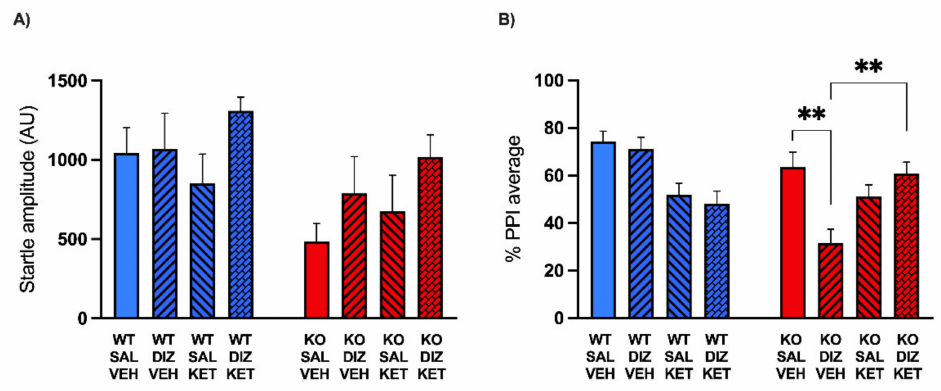
Figure 4. Effects of the medial prefrontal cortex (mPFC) infusion of ketanserin (KET, 0.05 µ g/side) on the changes in startle reflex ( A ) and prepulse inhibition ( B ) induced by dizocilpine (DIZ, 0.1mg/kg, IP) in MAOA KO mice. Data are shown as means ± SEM. Significance levels refer to the results of post hoc comparisons of three-way ANOVA analyses. Main effects are not indicated. ** p < 0.01 for com- parisons indicated by bracket lines. (SAL, saline; VEH, vehicle; AU, arbitrary units); n = 6–10/group. For further details, see results